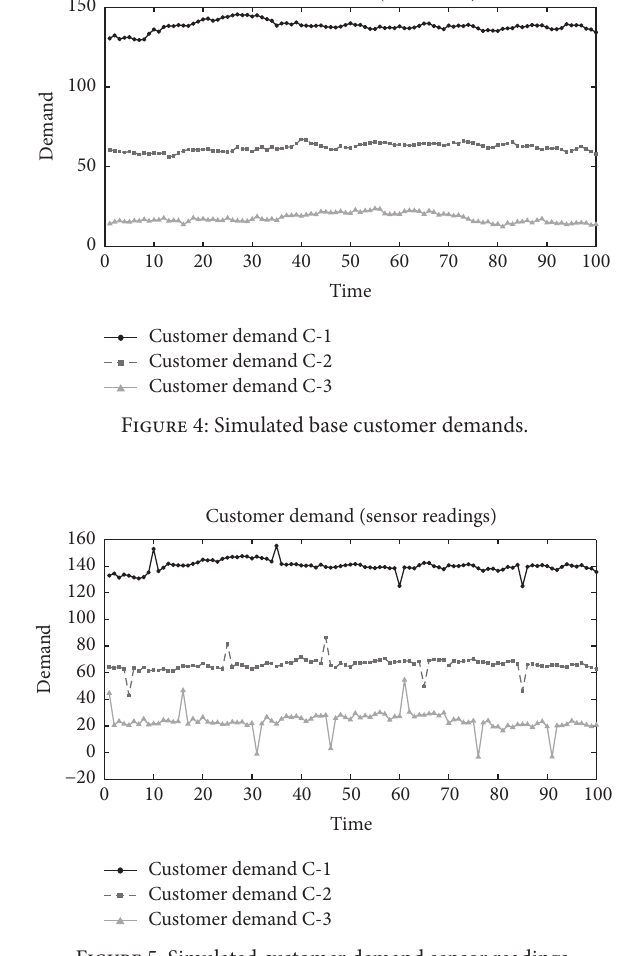
Figure 5: Simulated customer demand sensor